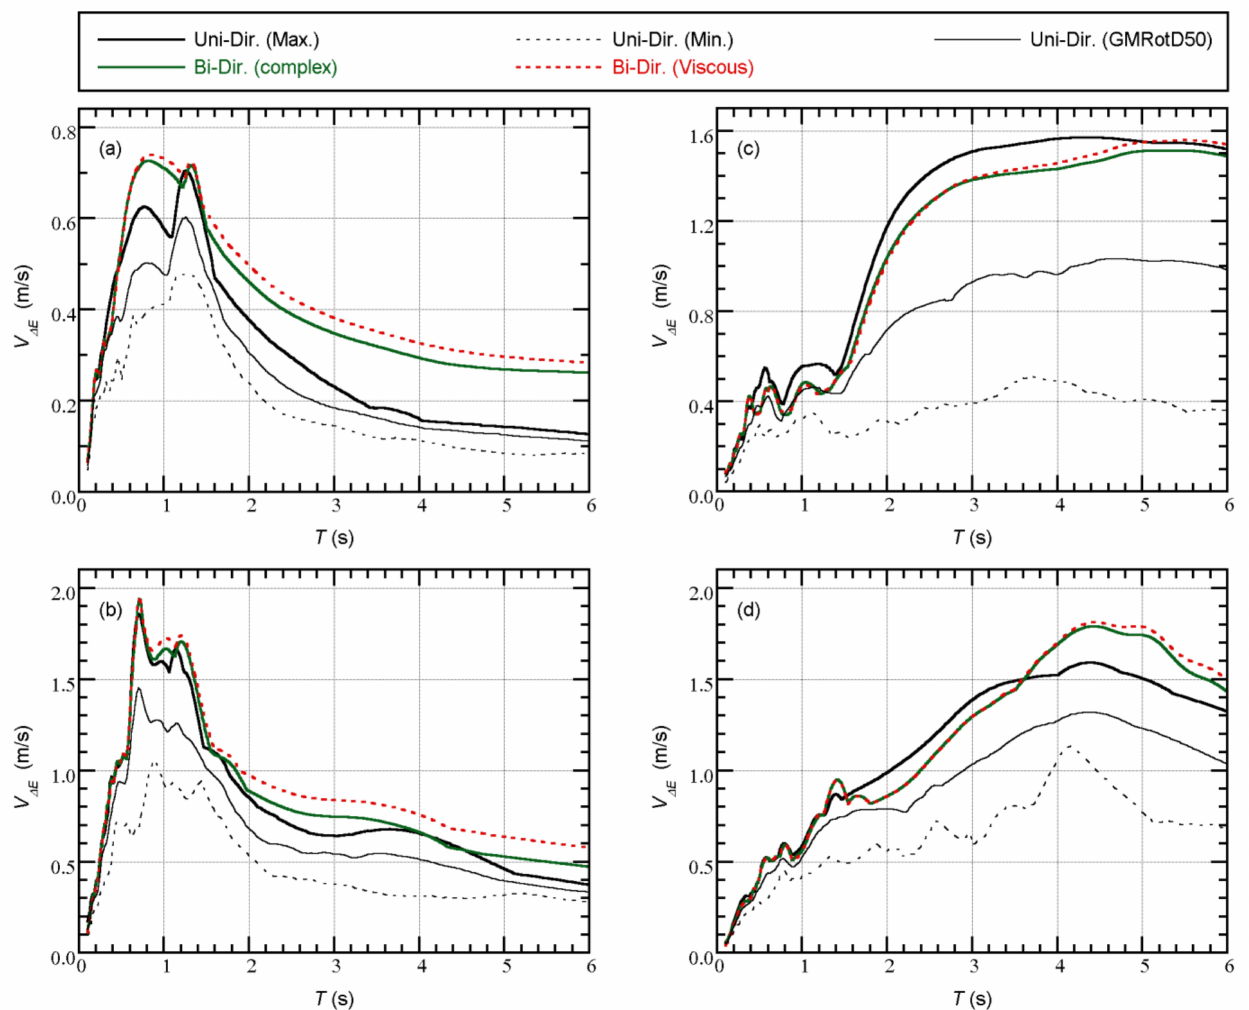
Figure A5. Comparisons of the unidirectional and bidirectional V ∆ E spectra for artificial ground motion datasets: ( a ) Art-1 series and ( b ) Art-2 series.